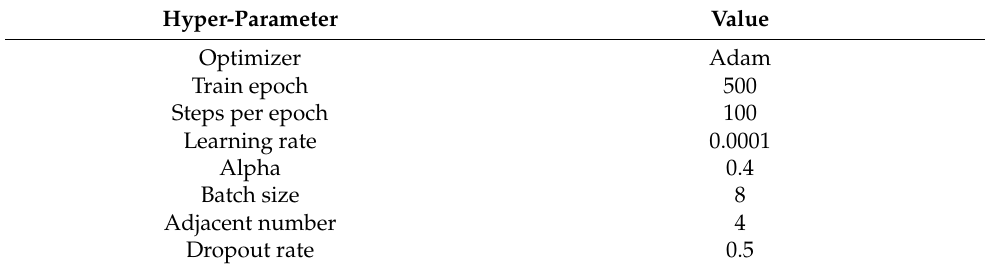
Figure 3. The flowchart of SE. As a feature extractor, Inception-V3 is removed from the final output layer, and the outputted feature maps with 2048 channels are fed into SE, where the channel attention mechanism is introduced to enhance the channel that are more effective for accurate predictions. Table 3. The hyper-parameter